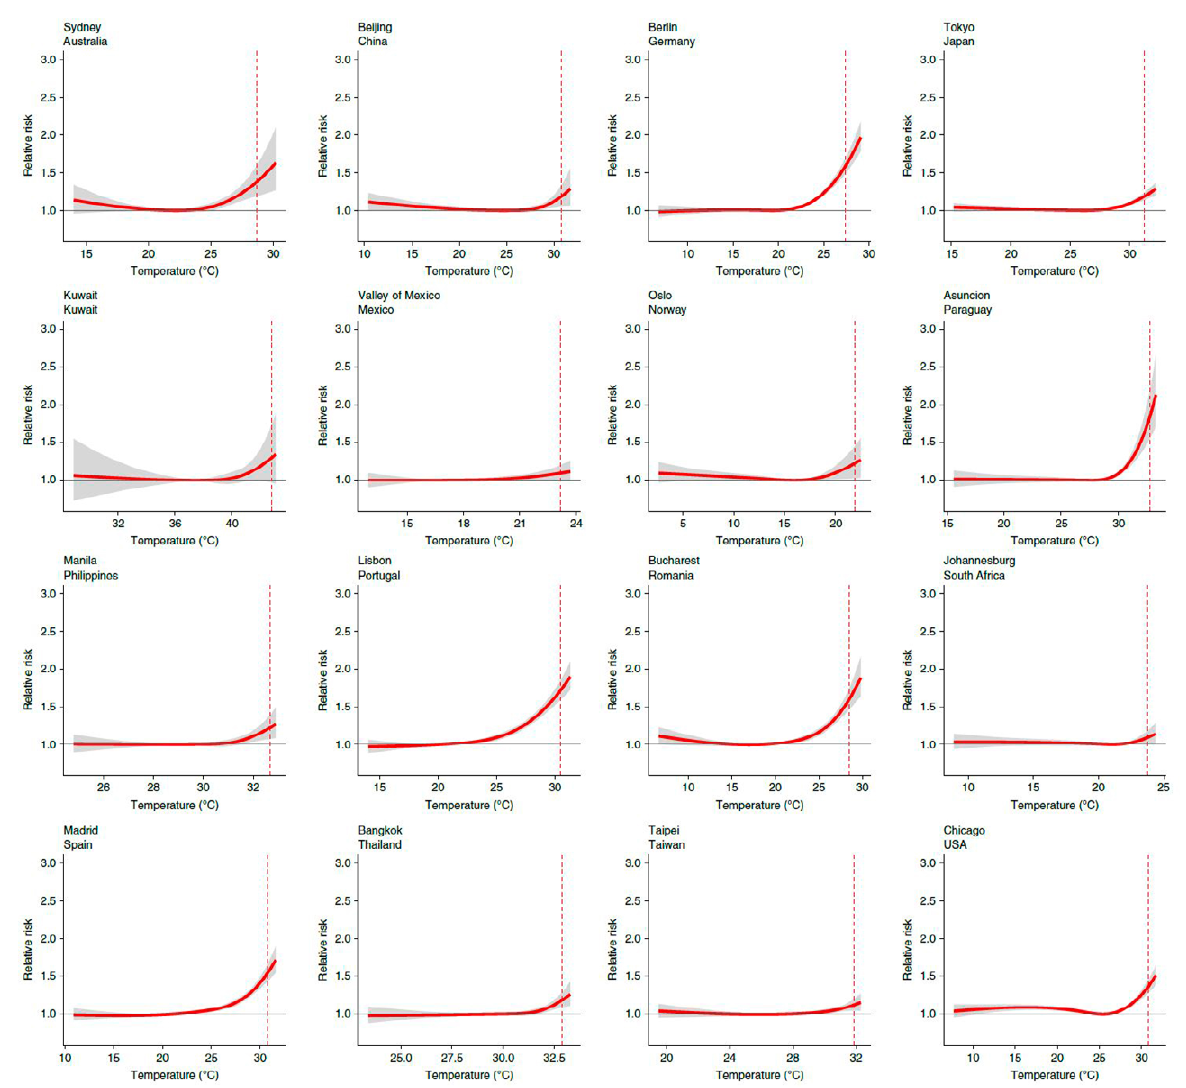
Figure 3. A) Heat-mortality relations for 16 representative cities where the functions represent the cumulative relative risk of death over a 10-days lag period for each temperature value. Exposure-response associations are estimated as best linear unbiased predictions and reported as relative risk (with 95 % CI, shaded grey) for a cumulative 10-days lag of warm-season temperature, versus the optimum temperature (temperature of minimum mortality) Source: Vicedo-Cabrera et al.,